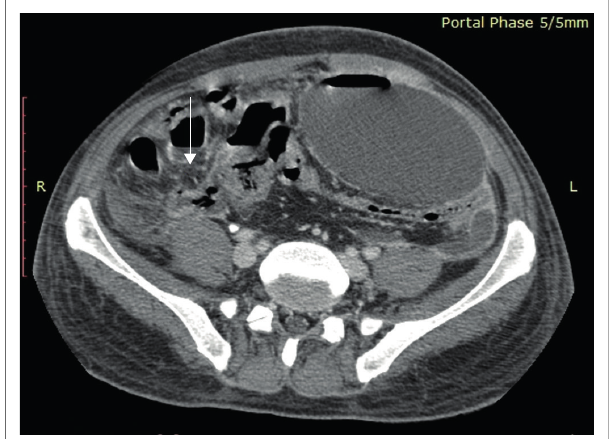
FIGURE 5: Contrast enhanced computed tomography in the axial plane shows a tubular blind-ending structure arising from antimesenteric border of the distal ileum with surrounding free air suggestive of a perforated Meckel’s diverticulum (white arrow).